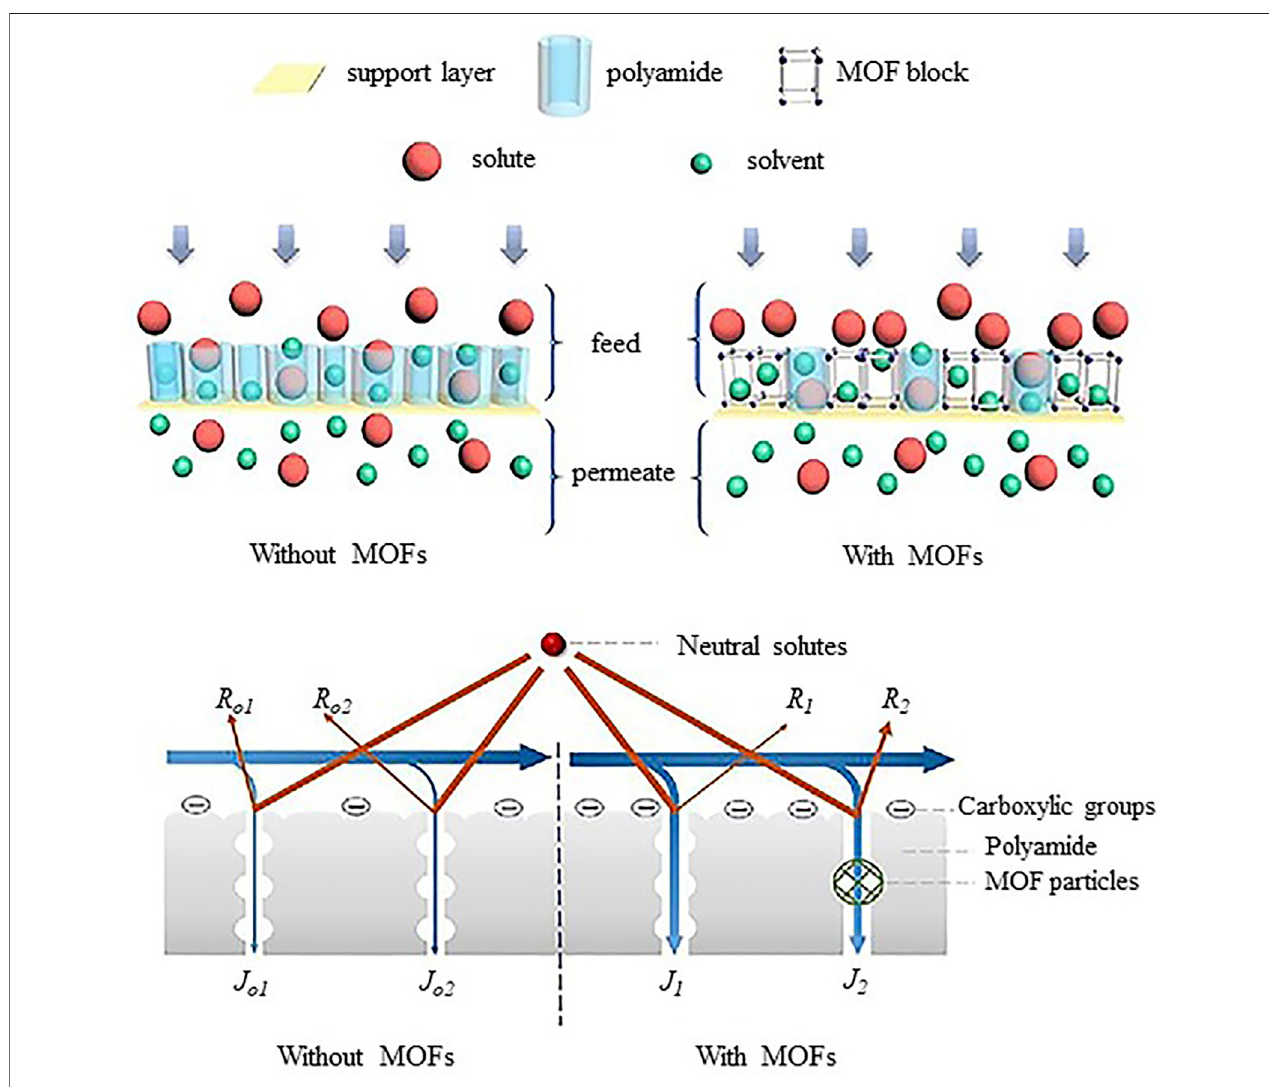
FIGURE 10 | Separation of solute by TFN membranes with and without MOFs (Liao et al., 2021).